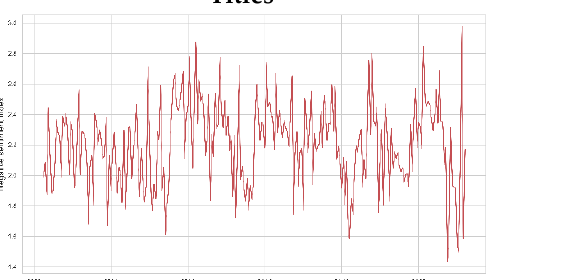
Figure A5. Sentiment analysis of news titles and leads over time for category “ Culture ” news.